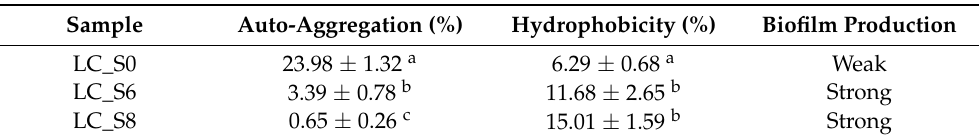
Table 3. Surface properties of sonicated and not-sonicated cells of Lacticaseibacillus casei ATCC 393. LC_S0: not-sonicated cells, control; LC_S6: treatment at 57 W with 50% DC for 6 min; LC_S8: treatment at 57 W with 50% DC for 8